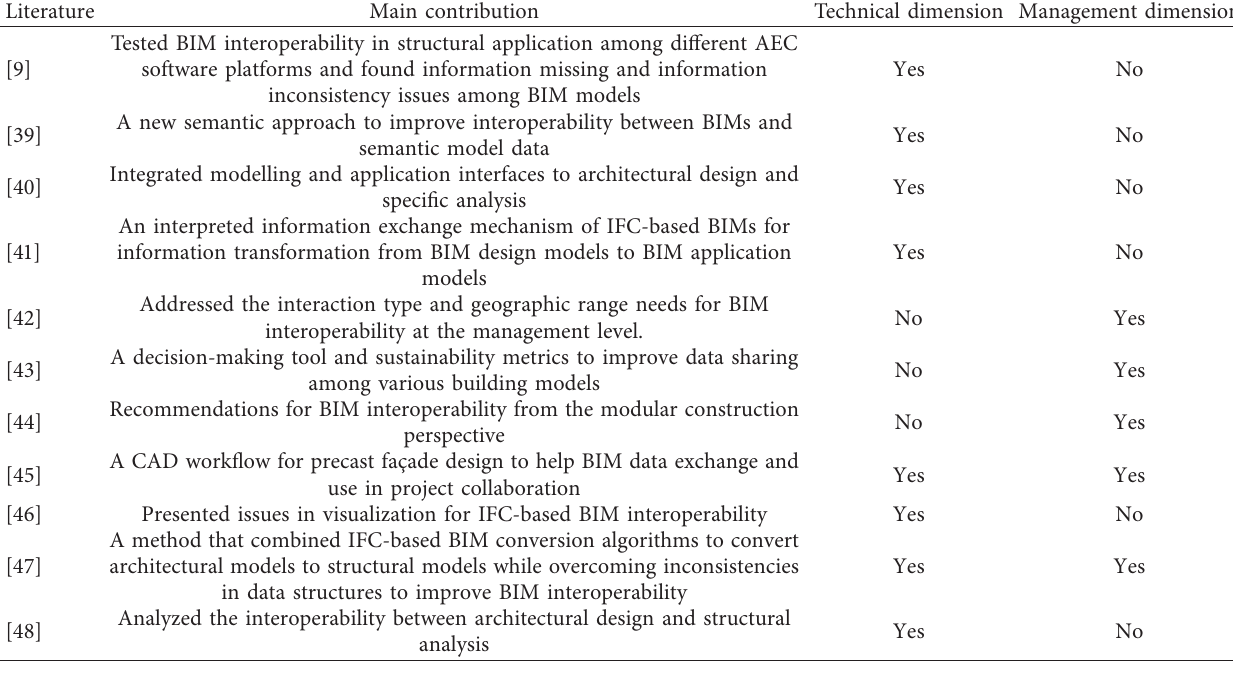
Table 1: Sample work on BIM interoperability between architectural model and analysis model from technical and process dimensions. Literature Main contribution